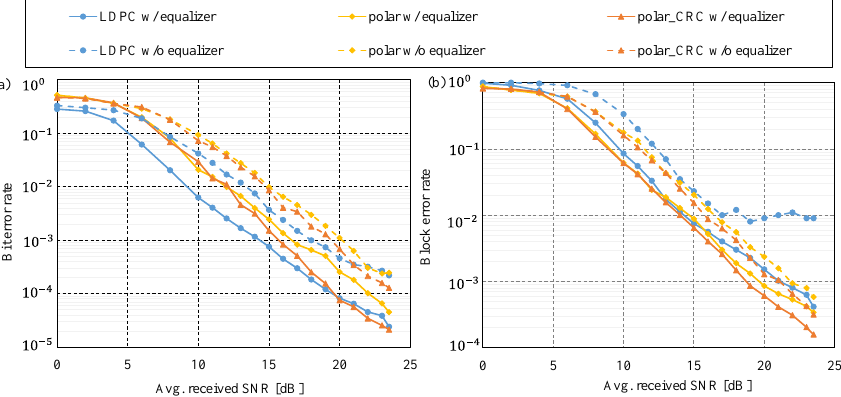
Figure 6. ( a ) BER and ( b ) BLER of experimental data. The solid and dotted lines are for the cases with and without channel equalization, respectively.